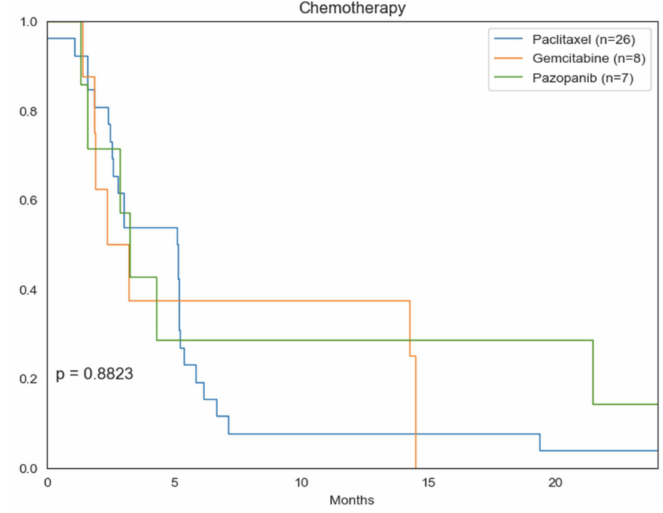
Figure 6. Kaplan–Meier curves comparing OS between chemotherapy regimens.